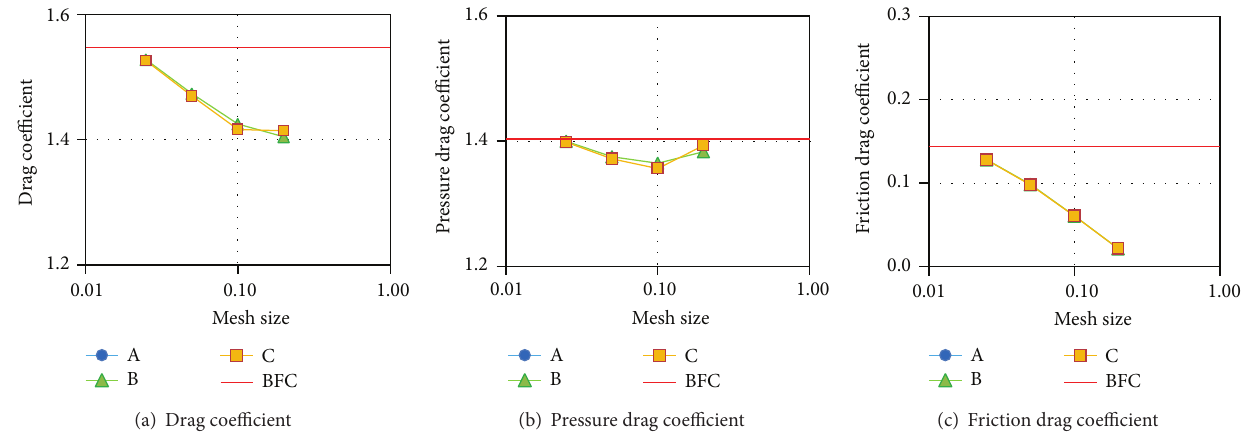
Figure 17: Effect of mesh size on drag coefficients at Mach 2.0. The red lines are reference values.